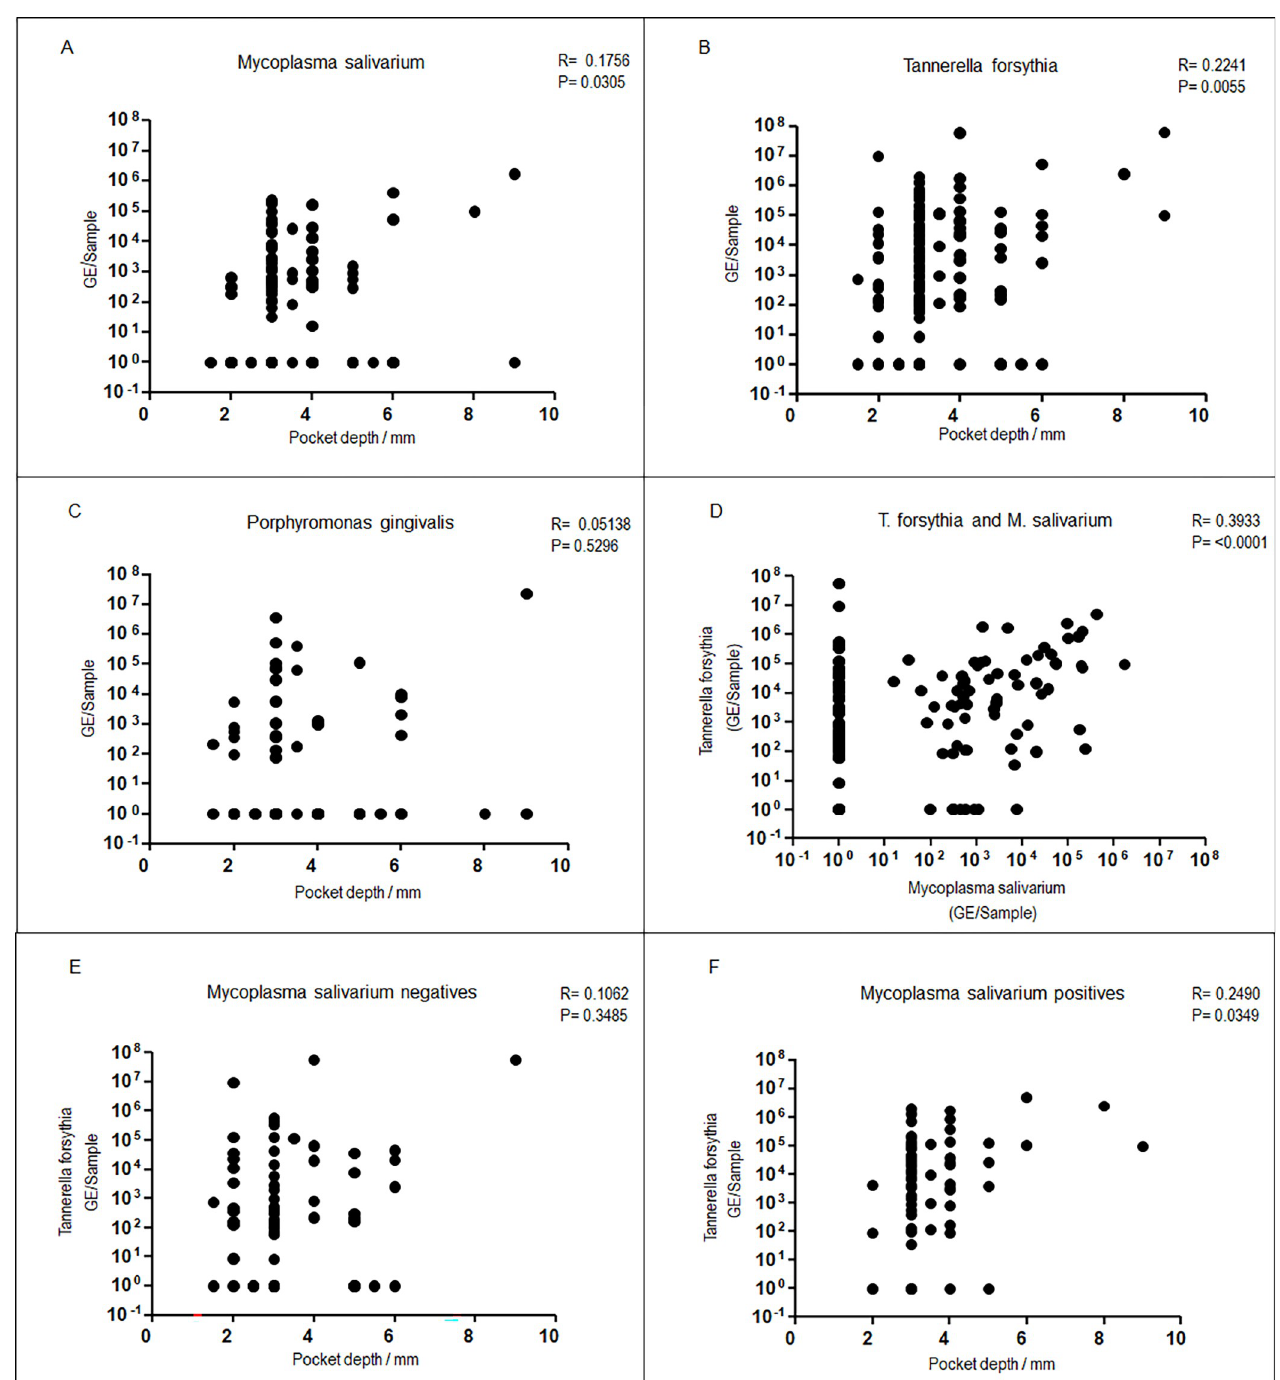
Fig 2. Correlation of bacterial abundance in the peri-implant sulcus with pocket depth or between bacterial species. Correlation of the load (GE/sample) of M . salivarium (A), T . forsythia (B) and P . gingivalis (C) to pocket depth (mm); of T . forsythia to M . salivarium (D); of M . salivarium negative samples (E) or M . salivarium positive samples (F) to pocket depth (mm). The bars represent mean.